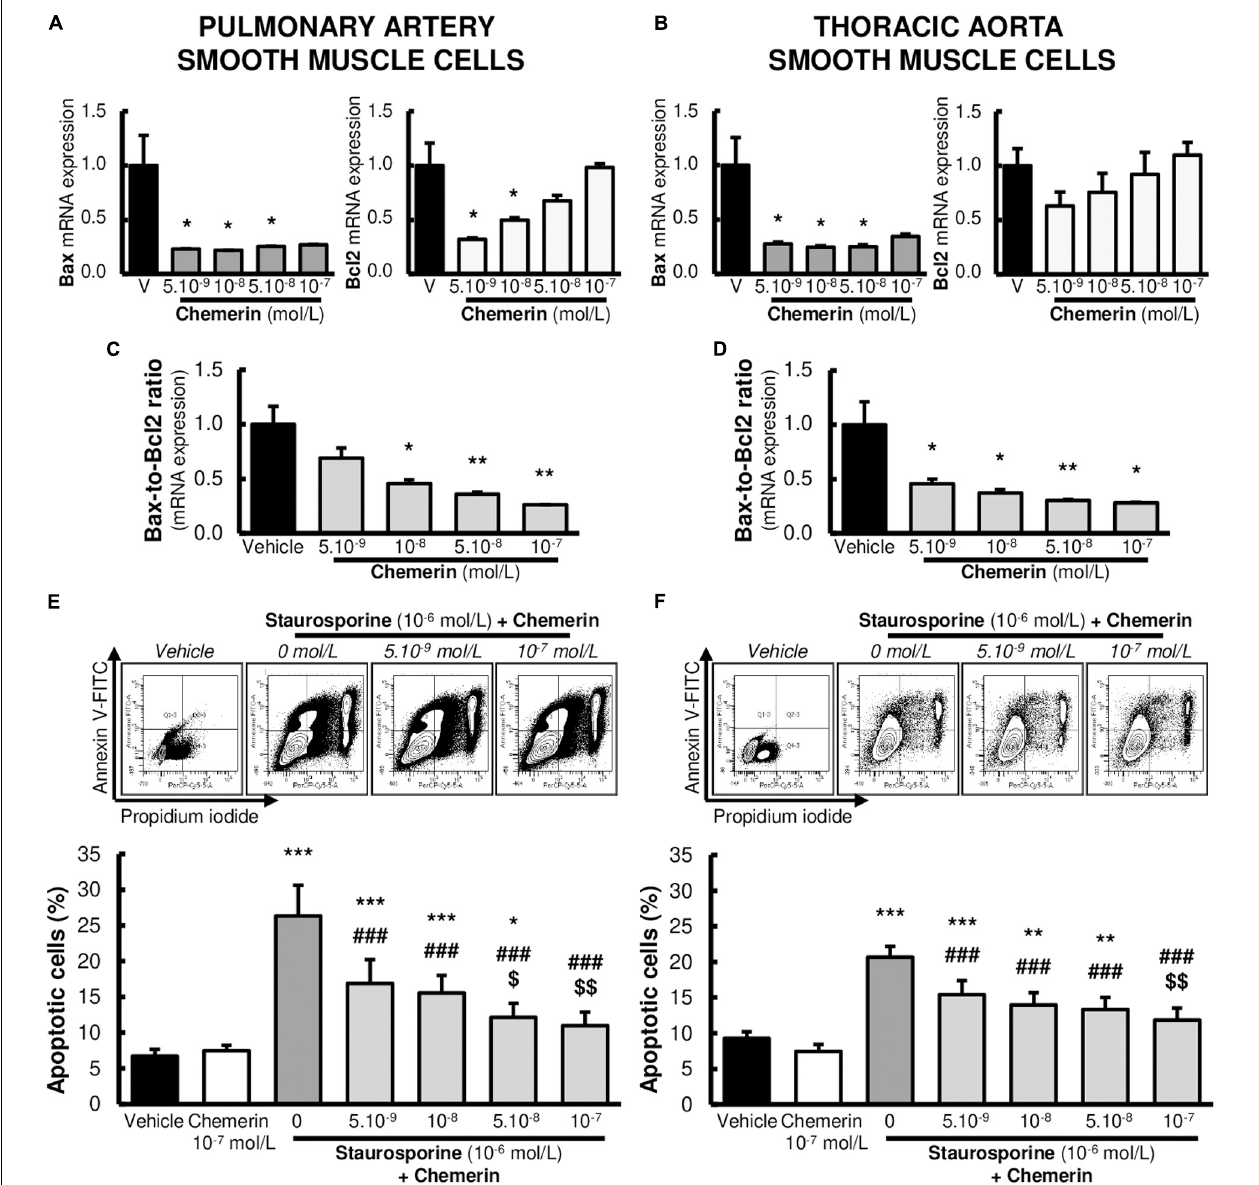
FIGURE 4 | Chemerin decreased the activation of apoptosis in pulmonary artery and thoracic aorta smooth muscle cells. Relative gene expressions of Bax, Bcl2, and pro-apoptotic Bax-to-Bcl2 ratio in primary cultured pulmonary artery [ (A,C) . six experiments in total] and thoracic aorta [ (B,D) , seven experiments in total] smooth muscle cells isolated from Wistar rats ( n = 5), treated with increasing concentrations of recombinant mouse chemerin (tested from 5.10 − 9 to 10 − 7 mol/L). Results were expressed as mean ± SEM. *0.01 < p < 0.05 and **0.001 < p < 0.01 compared to vehicle [0% fetal calf serum (FCS)]-treated smooth muscle cells in the same type of vessels. Representative FACS dot plots and quantification of annexin V/propidium iodide dual labeling in primary cultured pulmonary artery [ (E) , 14 experiments in total] and thoracic aorta [ (F) , 13 experiments in total] smooth muscle cells isolated from Wistar rats ( n = 8). After 24-h serum starvation, smooth muscle cells were treated with staurosporine (10 − 6 mol/L) with or without increasing concentrations of recombinant mouse chemerin (tested from 5.10 − 9 to 10 − 7 mol/L) for 24 h. Percentages of apoptotic cells corresponded to percentages of cells in early and late apoptosis. Results were presented as mean ± SEM. *0.01 < p < 0.05, **0.001 < p < 0.01 and *** p < 0.001 compared corresponding vehicle (0% FCS)-treated smooth muscle cells; ### p < 0.001 compared to corresponding staurosporine (10 − 6 mol/L)-treated smooth muscle cells; $ p < 0.05 and $$ 0.001 < p < 0.01 compared to corresponding chemerin (5.10 − 9 mol/L) and staurosporine (10 − 6 mol/L)-treated smooth muscle cells.